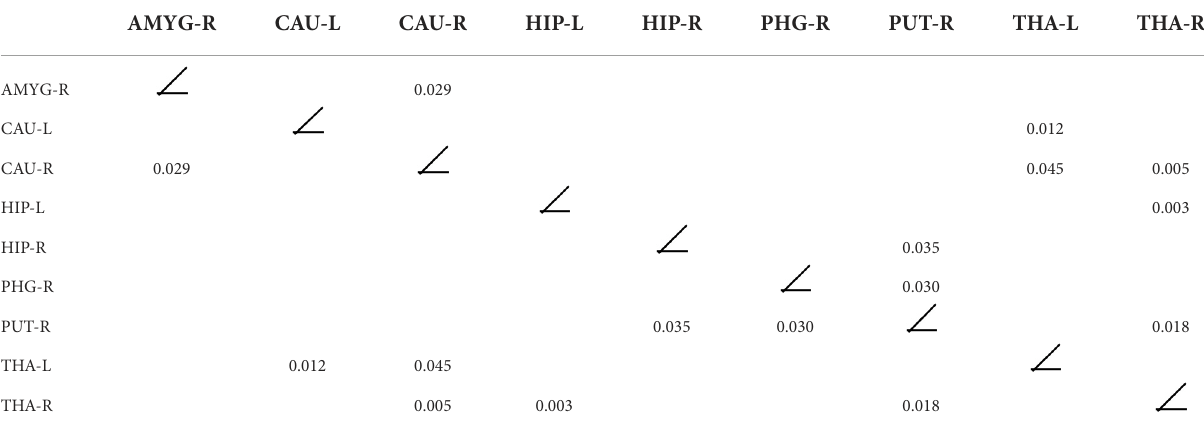
TABLE 4 Functional connectivity of the brain